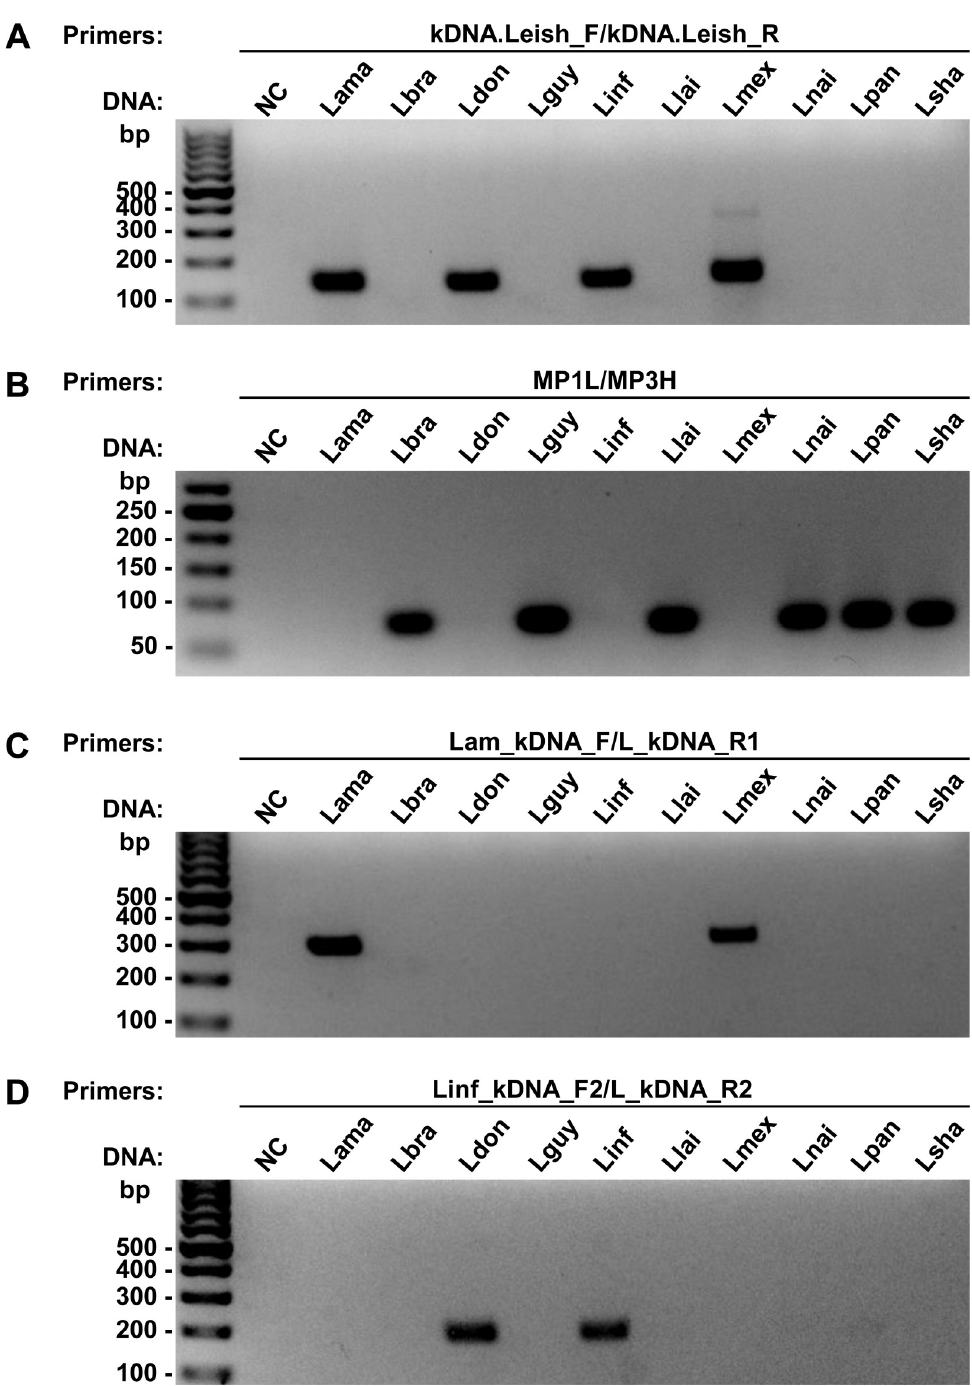
Fig 2. Specificity analysis of each pair of PCR primers tested in the study, using DNA from different species of Leishmania . (A) The pair of primer kDNA.Leish was specific for the Leishmania subgenus amplifying the DNA of L . amazonenis , L . donovani , L . infantum , and L . mexicana ; (B) the primers MP1L/MP3H were specific for the Viannia subgenus, amplifying the DNA of L . braziliensis , L . guyanensis , L . lainsoni , L . naiffi , L . panamensis , and L . shawi ; (C) the primers Lam_kDNA_F/L_kDNA_R1 amplify both L . amazonenis and L . mexicana ; and (D) the primers Linf_kDNA_F2/ L_kDNA_R2 amplify L . donovani and L . infantum . bp: molecular size marker in base pairs; NC: negative control (without DNA); DNA: Lama: L . amazonensis ; Lbra: L . braziliensis ; Ldon: L . donovani ; Lguy: L . guyanensis ; Linf: L . infantum ; Llai: L . lainsoni ; Lmex: L . mexicana ; Lnai: L . naiffi ; Lpan: L . panamensis ; Lsha: L . shawi .